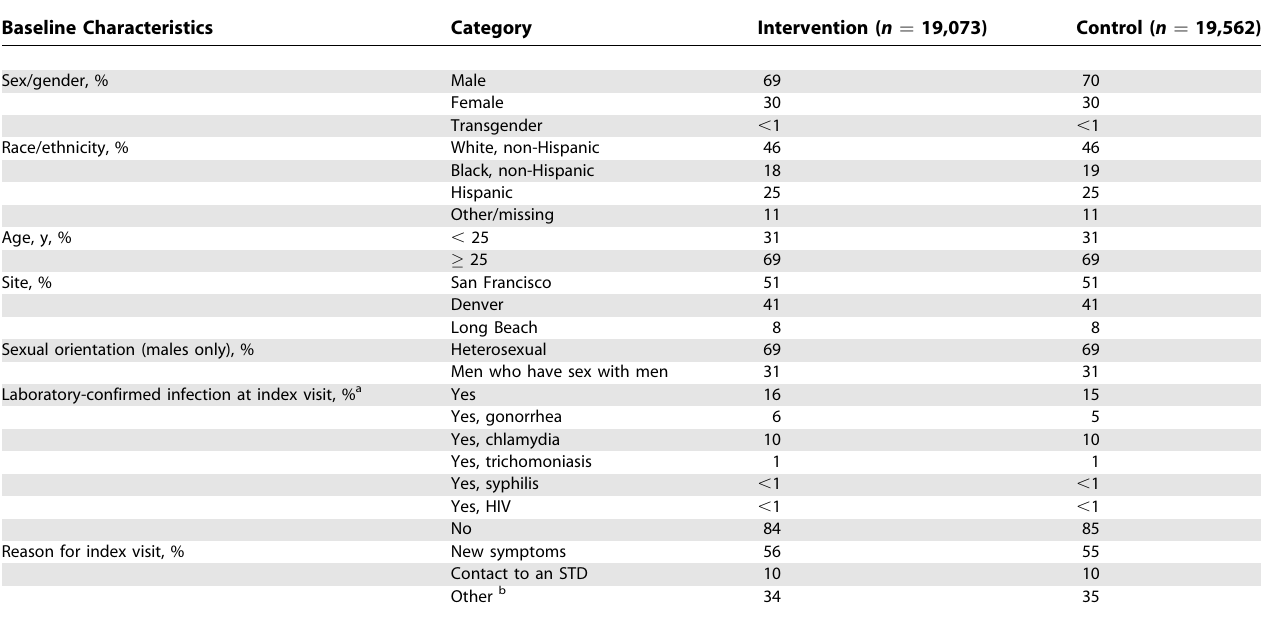
Table 1. Characteristics of 38,635 Patients Attending STD Clinics in Three U.S. Cities, December 2003–August 2005, by Study Condition Baseline